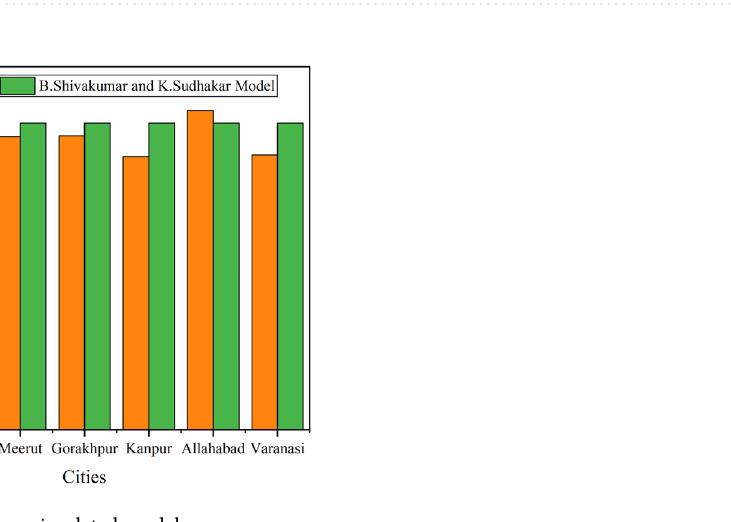
Table 5. Simulation output parameters. *Standard error = simulated values have a 14% higher deviation than the actual values 21 .